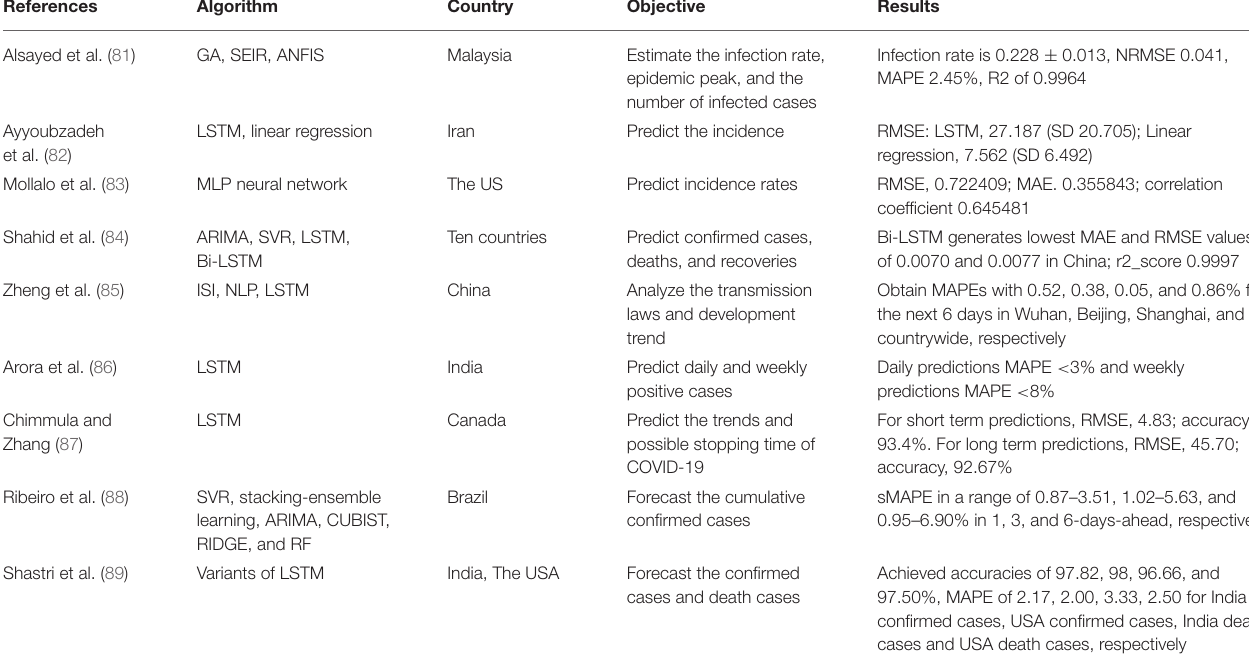
TABLE 5 | Application of AI in predicting the epidemic trend of COVID-19.